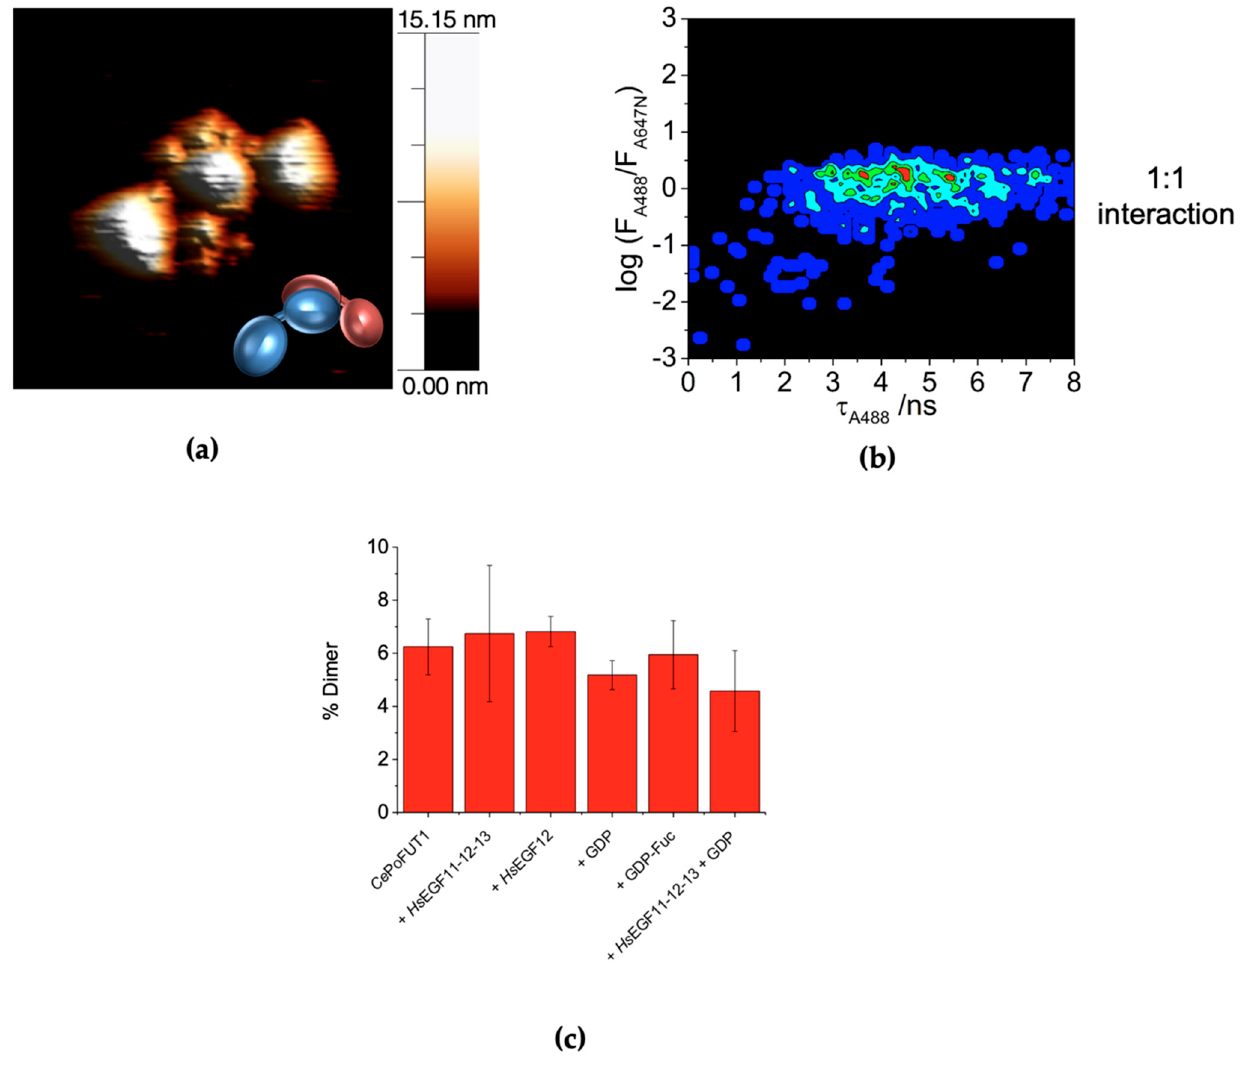
Figure 3. Ce PoFUT1 dimers. ( a ) AFM 3D image showing a Ce PoFUT1 dimer found when the enzyme was incubated with GDP and Hs EGF11-12-13. The feature appears next to outlined ball shapes that represent the species found. ( b ) Single- molecule coincidence correlogram (log( F A488 /F A647N ) vs. τ A488 ) of a mixture of singly-labeled Ce PoFUT1-A488 and Ce PoFUT1- A647N. ( c ) Ce PoFUT1 dimer percentage found in solution in the presence of different substrates.